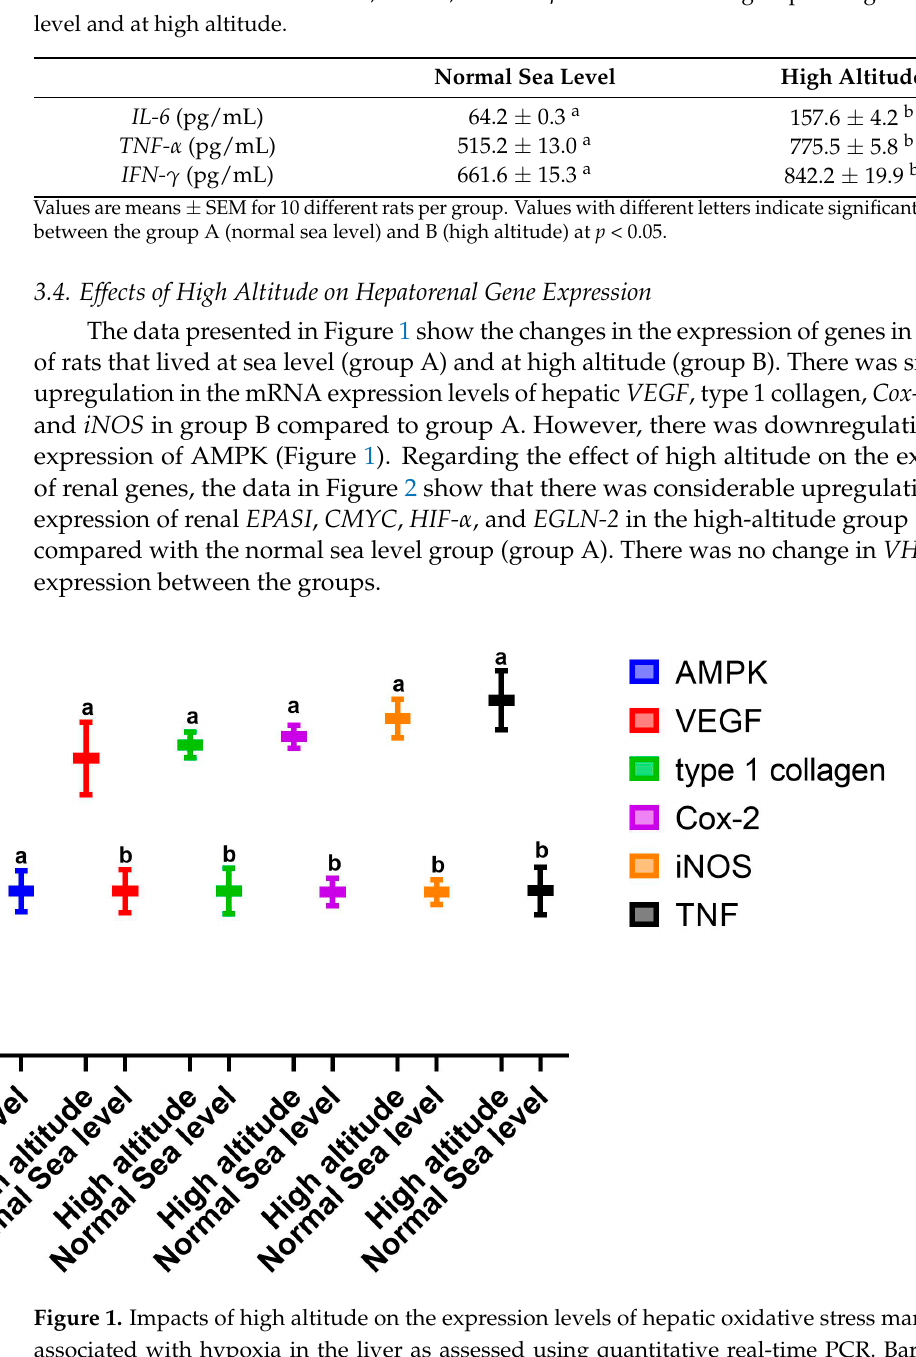
Figure 2. Impacts of high altitude on the expression levels of renal oxidative stress marker genes associated with hypoxia in the kidneys as assessed using quantitative real-time PCR. Bars indicate densitometric analysis of the expression levels of the examined genes for 10 different rats per group. Bars with different letters indicate significant differences between groups A (normal sea level) and B (high altitude) at p < 0.05.